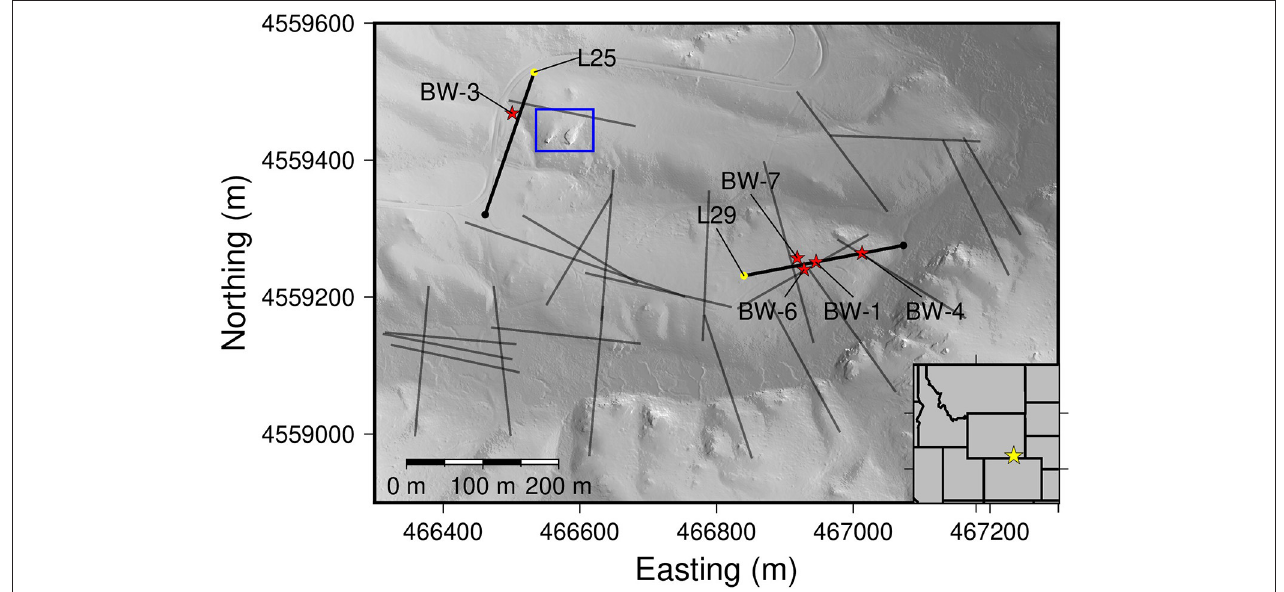
FIGURE 3 | A hill shaded relief map of the study site. The outcrop near BW-3 and L25 is highlighted by a blue box. Red stars indicate the locations of boreholes. The two lines used in this study are thick black lines, where the yellow point indicates the start of the profile. The thin transparent profiles are existing seismic refraction lines presented by Flinchum et al. (2018a,b). The boreholes BW-6, BW-7, BW-1, and BW-4 are all within 70m of each other.